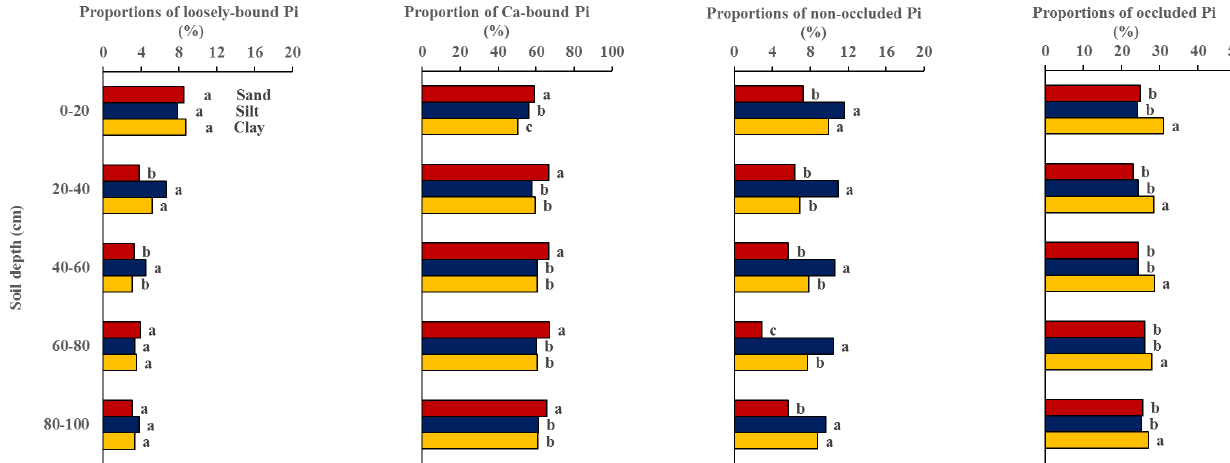
Figure 6. The proportion of Pi forms in particle-size fractions in soil profiles. Values followed by a similar letter in the same layer are not significantly different at P< 0 . 05 level of significance according to the LSD